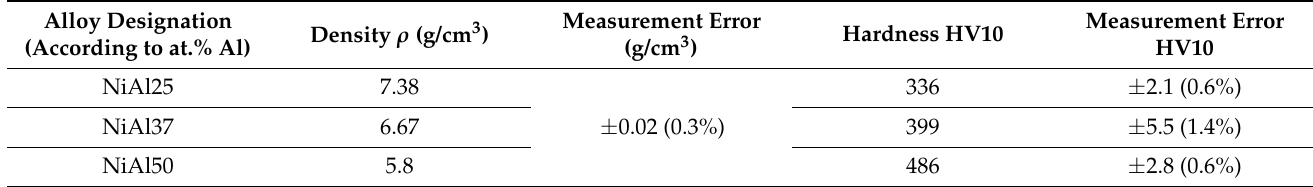
Table 1. The results of the density and HV10 hardness